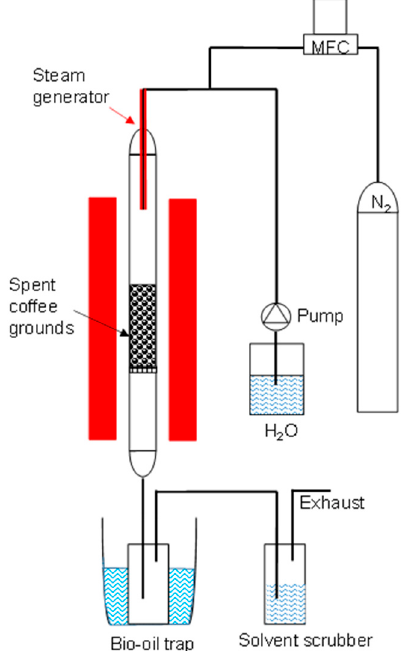
Figure 1. Pyrolysis and steam activation setup.